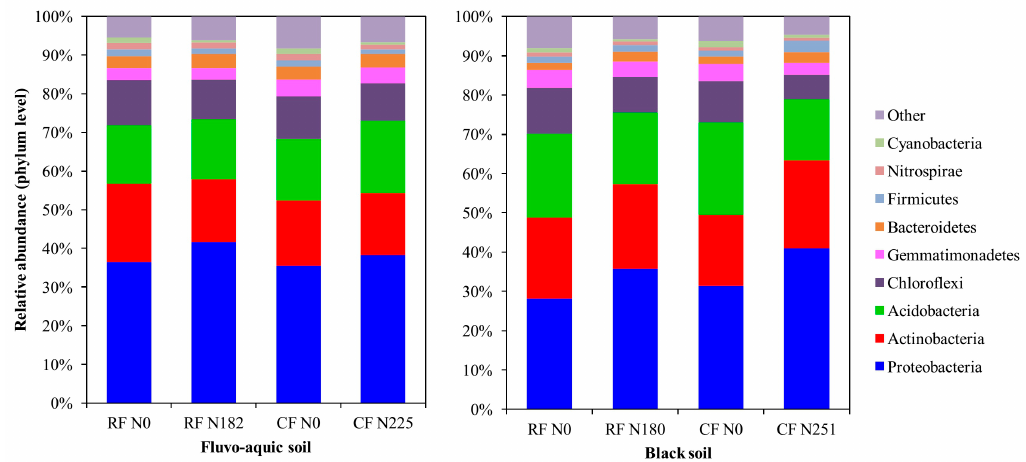
Figure 4. The relative abundances of dominant bacterial groups (phylum level) in fluvo-aquic soil and black soil, based on the proportional frequencies of 16S rRNA sequences.